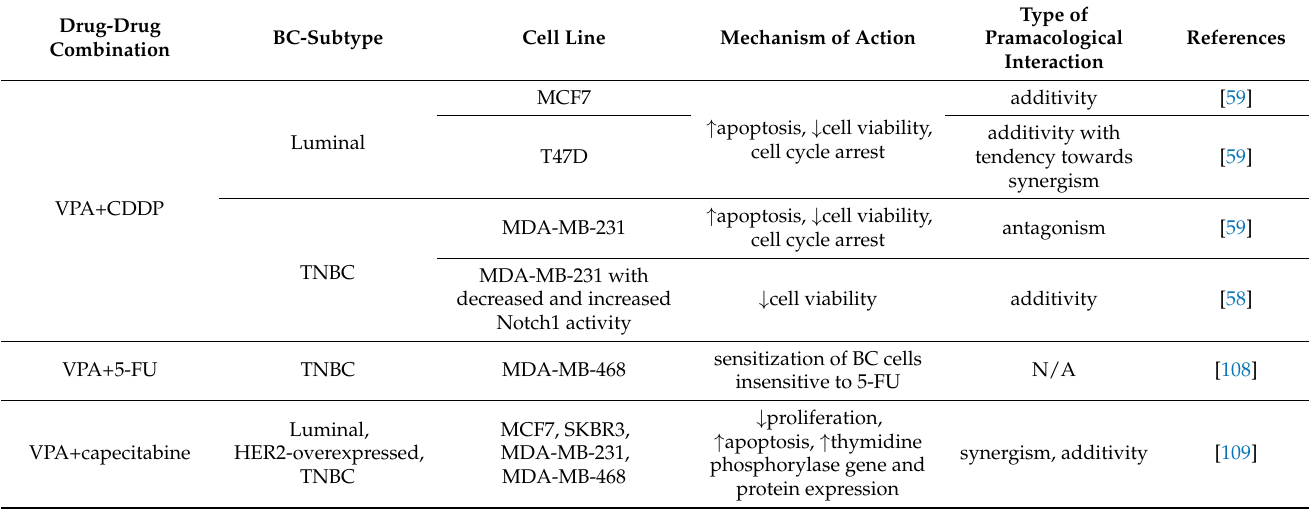
Table 4. Mechanism of action of valproic acid (VPA) and other anti-cancer drugs in combination in in vitro and in vivo breast cancer (BC) pre-clinical setting (CDDP-cisplatin, CDK-cyclin-dependent kinase, DXR-doxorubicin, 5-FU-5-fluorouracil, HER2-human epidermal growth factor receptor 2, N/A-not analyzed, PARP-poly (ADP-ribose) polymerase 1, TNBC-triple- negative breast